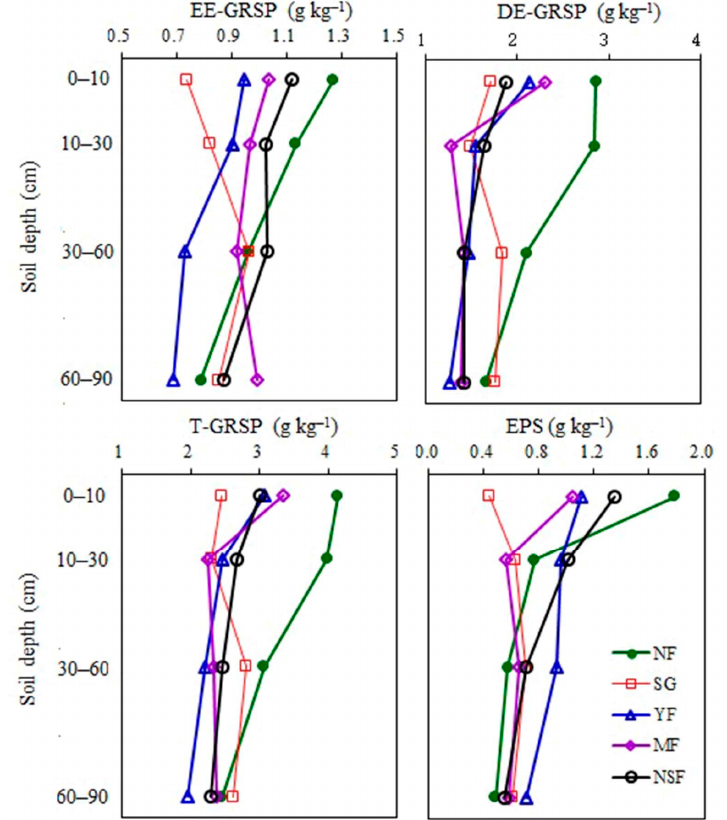
Figure 3. Distributions of glomalin-related soil protein (GRSP) and extracellular polysaccharide (EPS) concentrations for five vegetation types. EE-GRSP, easily extractable GRSP; DE-GRSP, diffi- cultly extractable GRSP; T-GRSP, total extractable GRSP. NF, natural forest; SG, shrub-grass land; PF, coniferous Pinus forest; MF: coniferous and broad-leaved mixed forest; NSF, natural secondary forest.